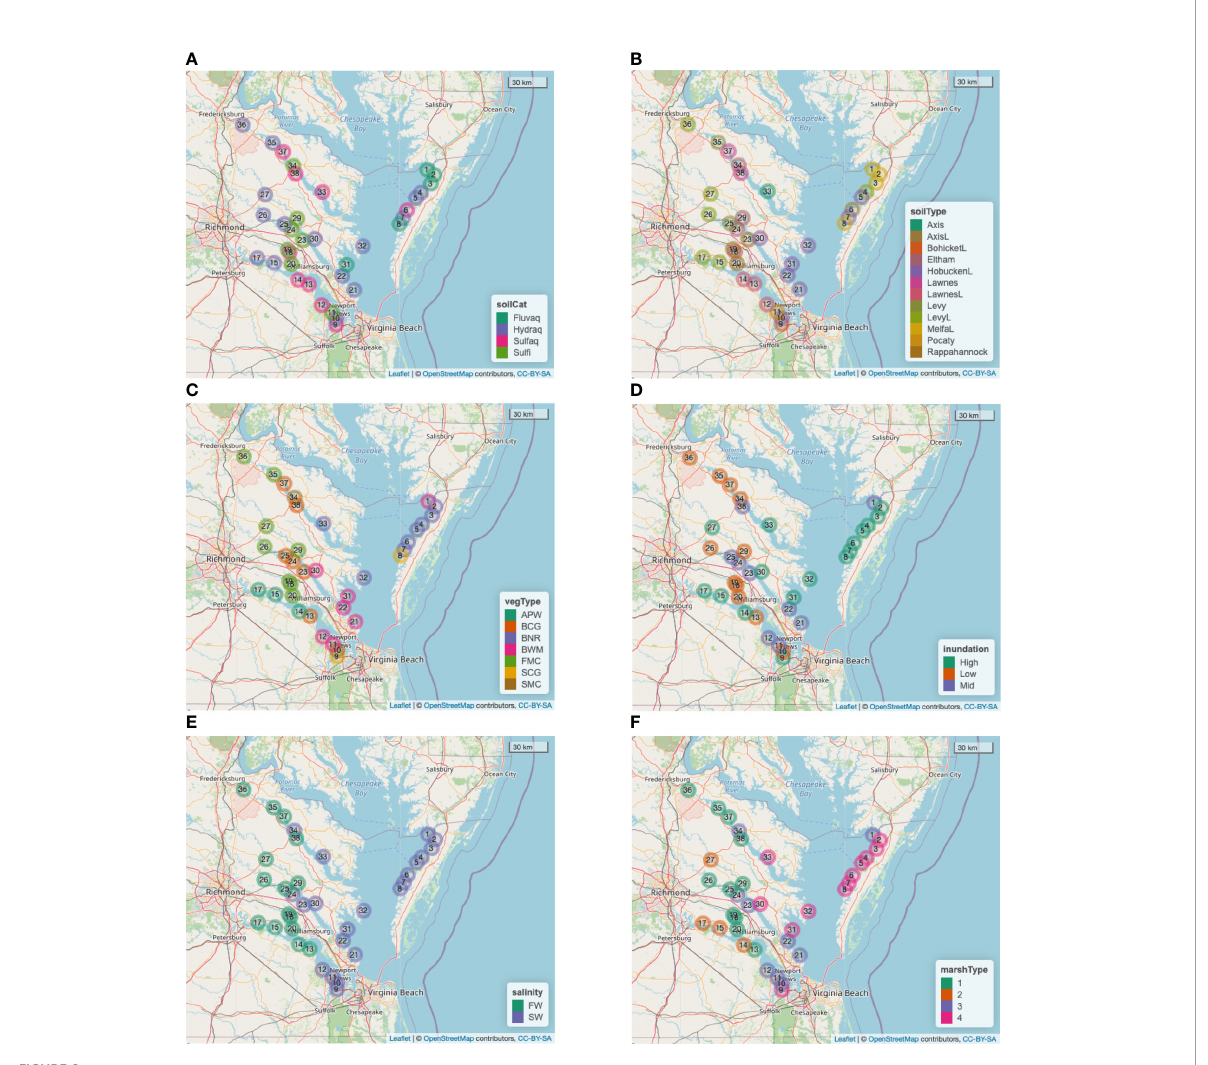
FIGURE 2 Spatial distributions of categorical variables across the 36 marshes considered for modeling (i.e., excluding Sites 16 and 28). (A) Soil category (Fluvaquents, Hydraquents, Sulfaquents, Sul fi hemists). (B) Soil type ( “ L ” at the end of a category denotes “ loam ” ). (C) Vegetation type . (D) Inundation . (E) Salinity (Freshwater, Saltwater). (F) Newly de fi ned Marsh type by crossing Inundation with Salinity ( ‘ 1 ’ =Low/Mid – FW, ‘ 2 ’ =High – FW, ‘ 3 ’ =Low/Mid – SW, and ‘ 4 ’ =High –